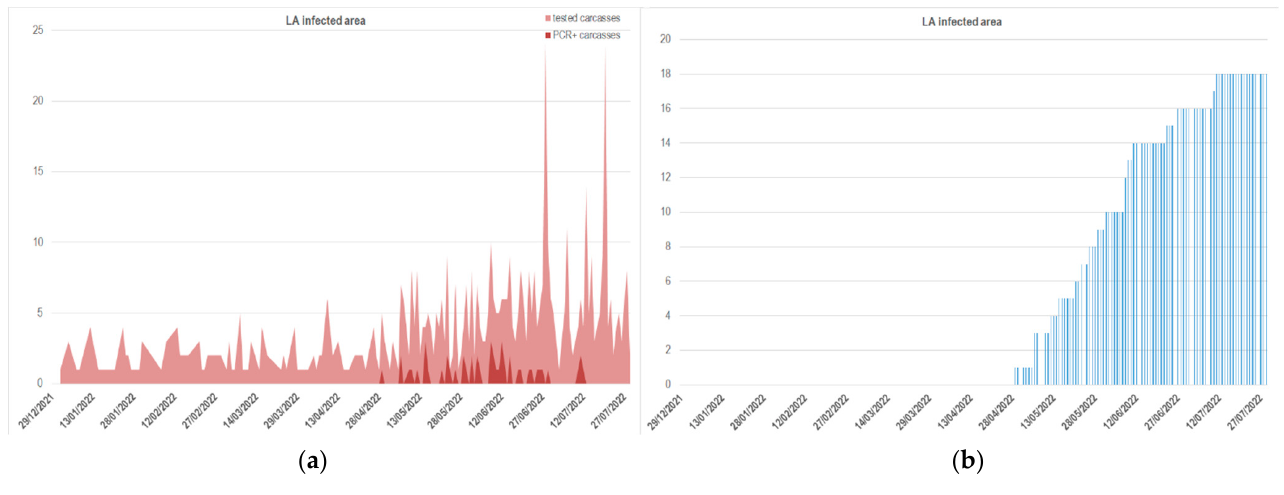
Figure 3. The time series illustrate ( a ) the number of samples from each type of carcass with ASF collected (light red curve) and the number of samples from fresh carcasses tested as PCR+ in Lazio, and ( b ) the cumulated frequencies of these samples over time.